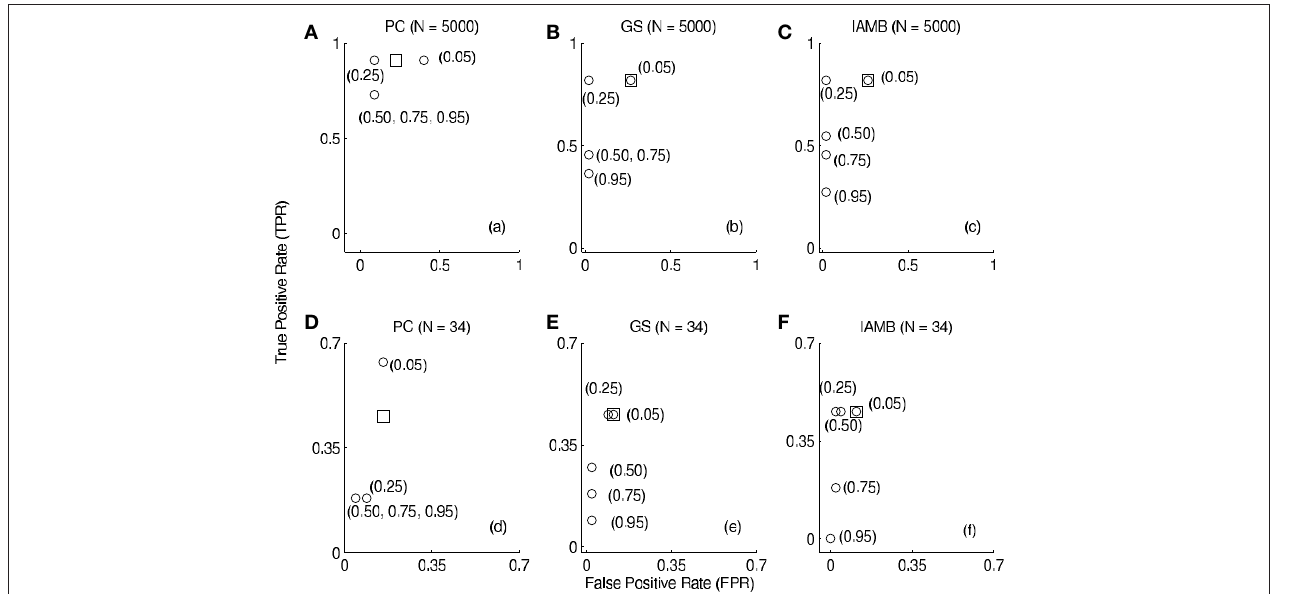
Figure 1 | (FPr, TPr) obtained using ad hoc thresholds (circles) and those using the proposed algorithm (squares) across three BSL techniques (PC, gS, iAMB) and across two sample sizes [ N = 5000, (A–C)] and [ N = 34, (D–F)] for the ASiA network. The value of the ad hoc threshold ( θ = 0.05, 0.25,